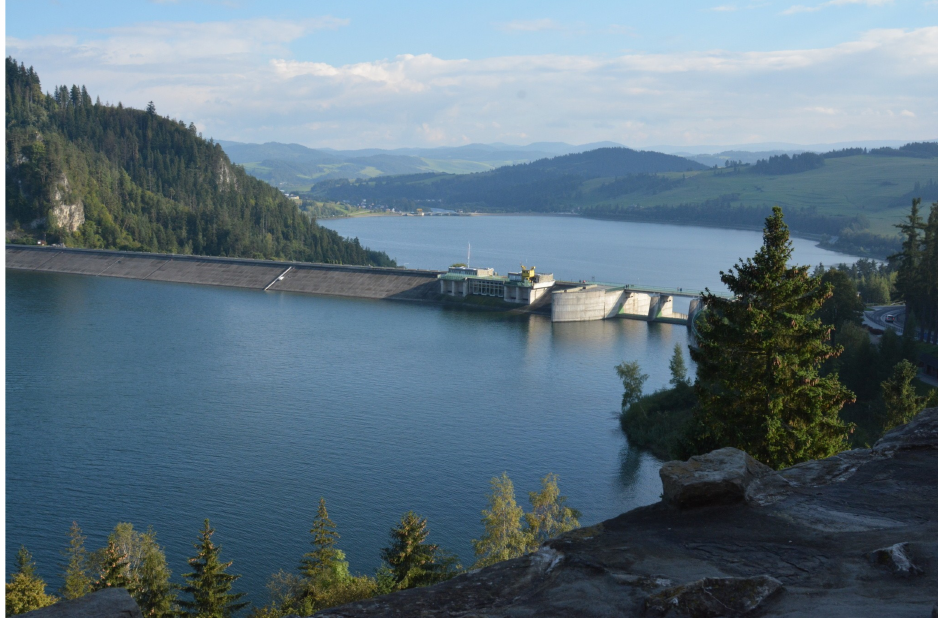
Figure 1. Czorsztyn recreational area in southern Poland (R.